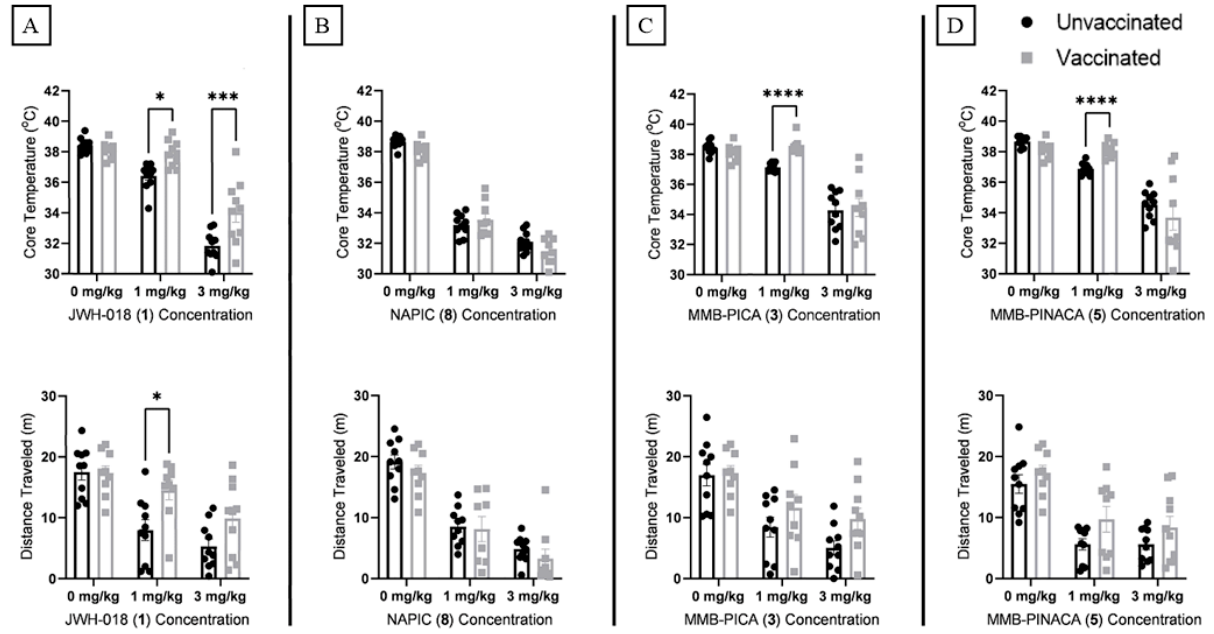
Figure 4. Core temperature and locomotion data for vaccine groups 1 through 4 (( A – D ), respectively). Results were analyzed by a two-way ANOVA with Šidák multiple comparison correction. p values: 0.05 (*), 0.001 (***) and 0.0001 (****). Data shown as Mean ± SEM.